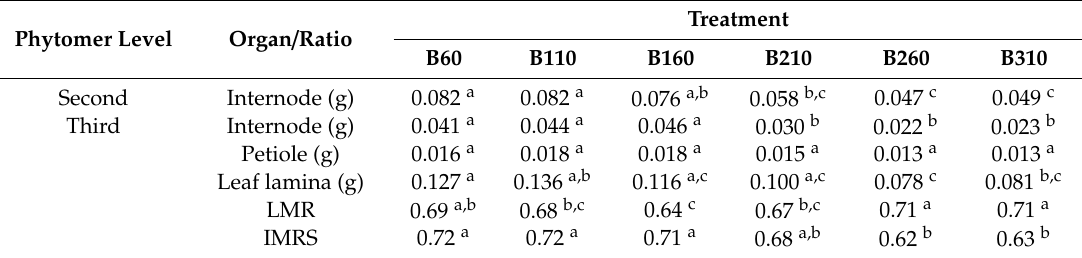
Table 1. Least square means of the final measurement of organ biomass, leaf mass ratio (LMR) and